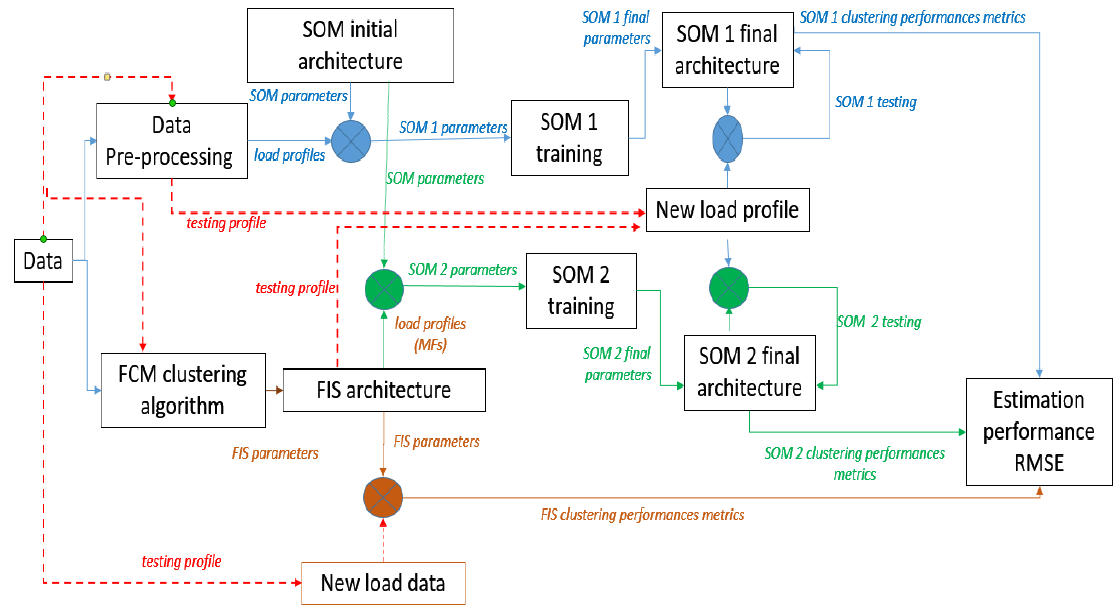
Figure 2. Classification approach flow based on SOM and FCM clustering.